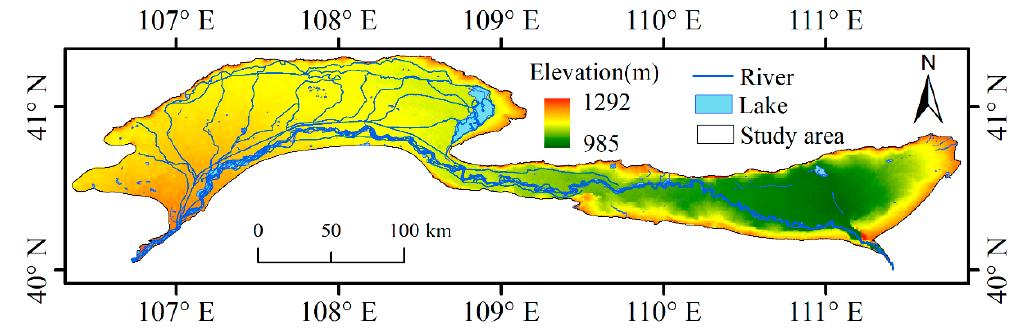
Figure 1. Geographic location and digital elevation model (DEM) of the Hetao Plain.